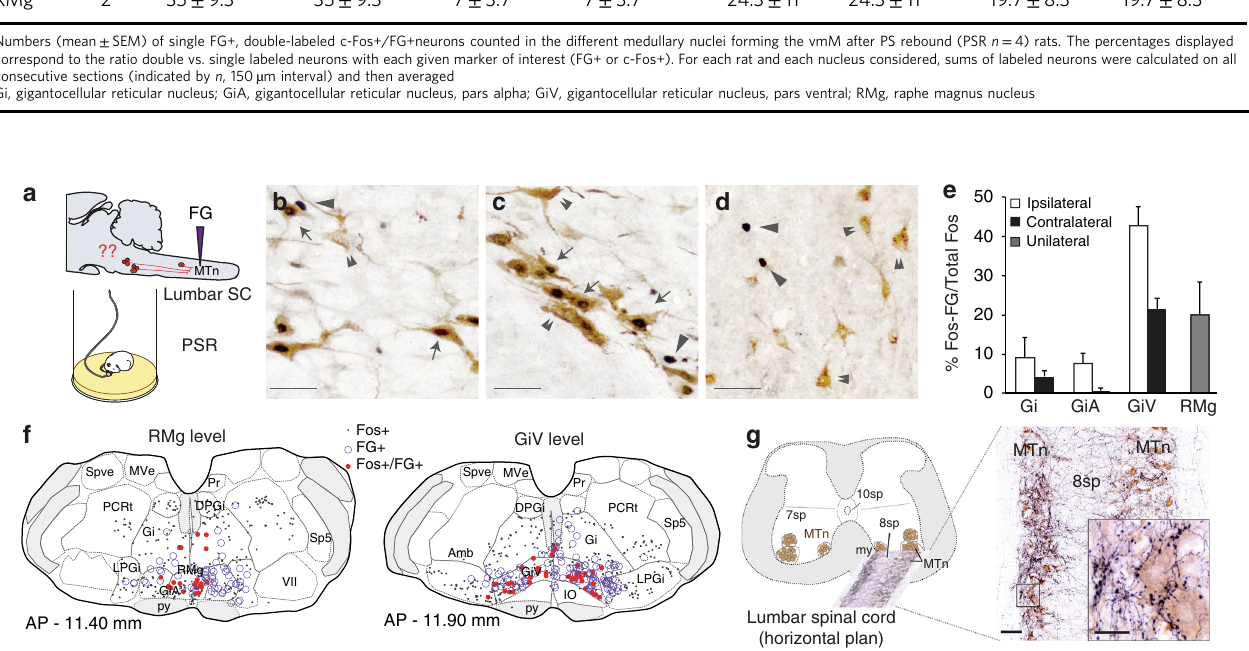
Fig. 2 Neurons of the vmM speci fi cally activated during PS send direct projections to the lumbar motoneurons. a Drawing illustrating the experimental paradigm with a FG injection in lumbar motoneurons at spinal L1 – L2 levels in rats allowed to sleep recover (PSR) after a 72-h deprivation of PS using the fl ower-pot method ( n = 4). b – d Photomicrographs at high magni fi cation of sections at the level of RMg ( b ), GiV ( c ), and 7 – 8 sp Rexed ’ s layers at lumbar SC ( d ), double immunostained for c-Fos and FG in a representative PSR rat. Neurons expressing c-Fos were colored in black (nuclear staining, arrowheads) whereas FG+ neurons were colored in brown(cytoplasmic staining, double arrowhead). Notice the massive numbers of double-labeled neurons c-Fos+/FG + (arrows) in RMg and GiV compared to lumbar SC where scattered, if any c-Fos+/FG+ cells are seen after PS recovery. e Percentage of c-Fos+ neurons in the vmM that are retrogradely labeled after a FG injection in the lumbar SC (PSR n = 4, values are mean ± SEM). f Drawings of two frontal medulla sections illustrating the bilateral distribution of single FG+ (violet circles), single c-Fos+ (black dots), and double-labeled c-Fos+/FG+ neurons (red dots) in the RMg and GiV in the same PSR rat. g Photomicrograph overview of one horizontal lumbar section at the level of 7 – 8 sp Rexed ’ s layers showing fi bers emanating from transducted GABA/glycine vmM neurons with AAV as immunolabeled for mCherry (black fi bers). Notice the very high density of mCherry immunolabeled fi bers surrounding the soma of lumbar motoneurons (brown cytoplasmic staining), often in close apposition with them suggesting that vmM neurons have direct synaptic contacts with somatic motoneurons. Scale bars: 40 µ m in b – d ; 50 µ m in g overview and 20 µ m in enlarged